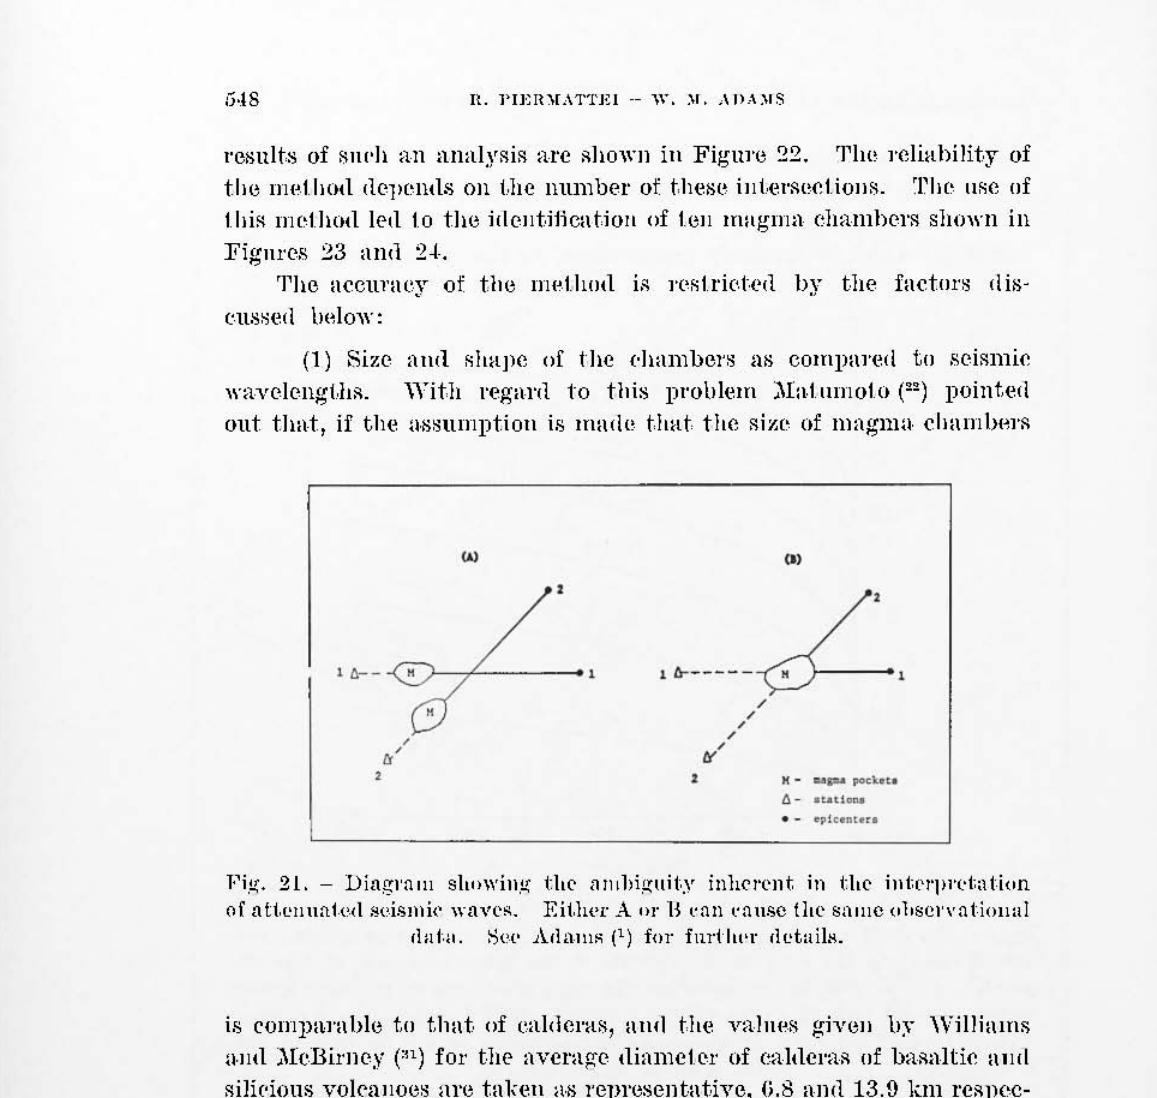
Fig. 21. - Diugl'uill showing the UIIIIJiguit,y inhe!'l'nt in the intl'l'])l'(.'tation of utt.l'llIHl1('llsdsmk I\'uvl'~.